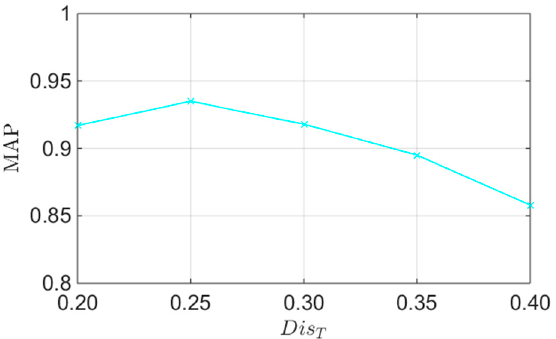
Dis on accuracy. Figure 8. The e T on